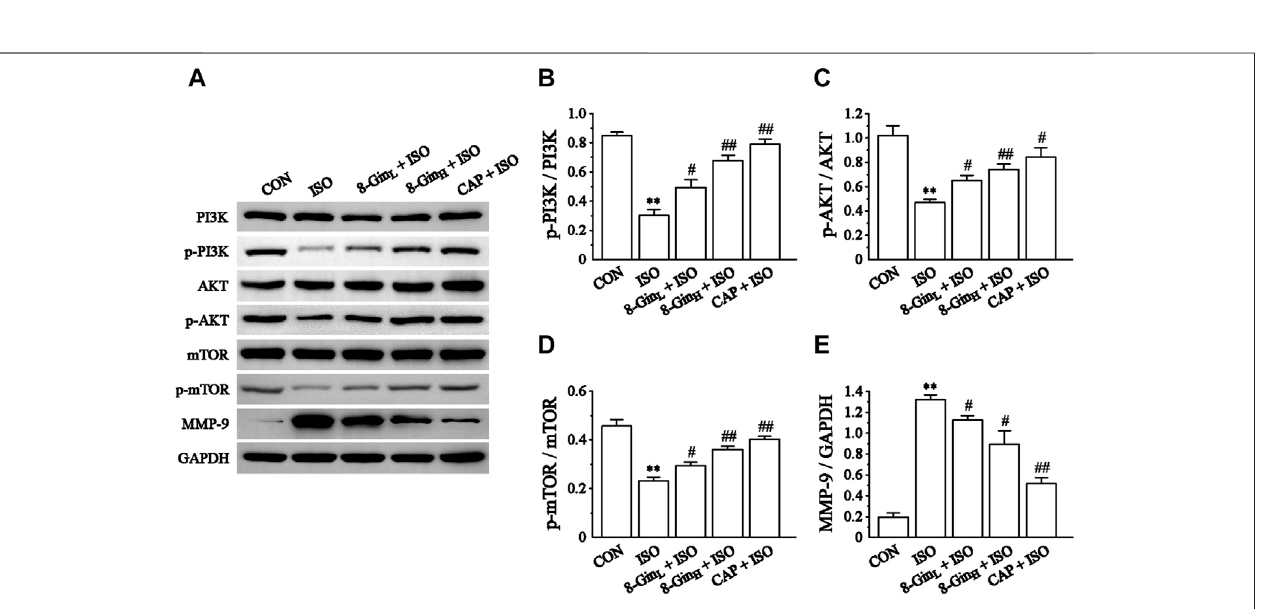
FIGURE8| Effectsof8-GinontheexpressionofthePI3K/AKT/mTORsignalingpathwayrelevantproteinsandMMP-9protein. (A) RepresentativeimagesofPI3K/ AKT/mTOR signaling pathway protein and MMP-9 protein expression were exhibited from cardiac tissue in the CON, ISO, 8-Gin L + ISO, 8-Gin H + ISO, and CAP + ISO groups. (B – D) Pooled analysis of PI3K, p -PI3K, AKT, p-AKT, mTOR, and p-mTOR protein expression by western blot analysis on which intensity was normalized to GAPDH. (E) Pooled analysis of MMP-9 protein expression by western blot analysis on which intensity was normalized to GAPDH. Data are shown as the mean ± SEM, n (cid:1) 3. ** p < 0.01 vs. the CON group; # p < 0.05, ## p < 0.01 vs. the ISO